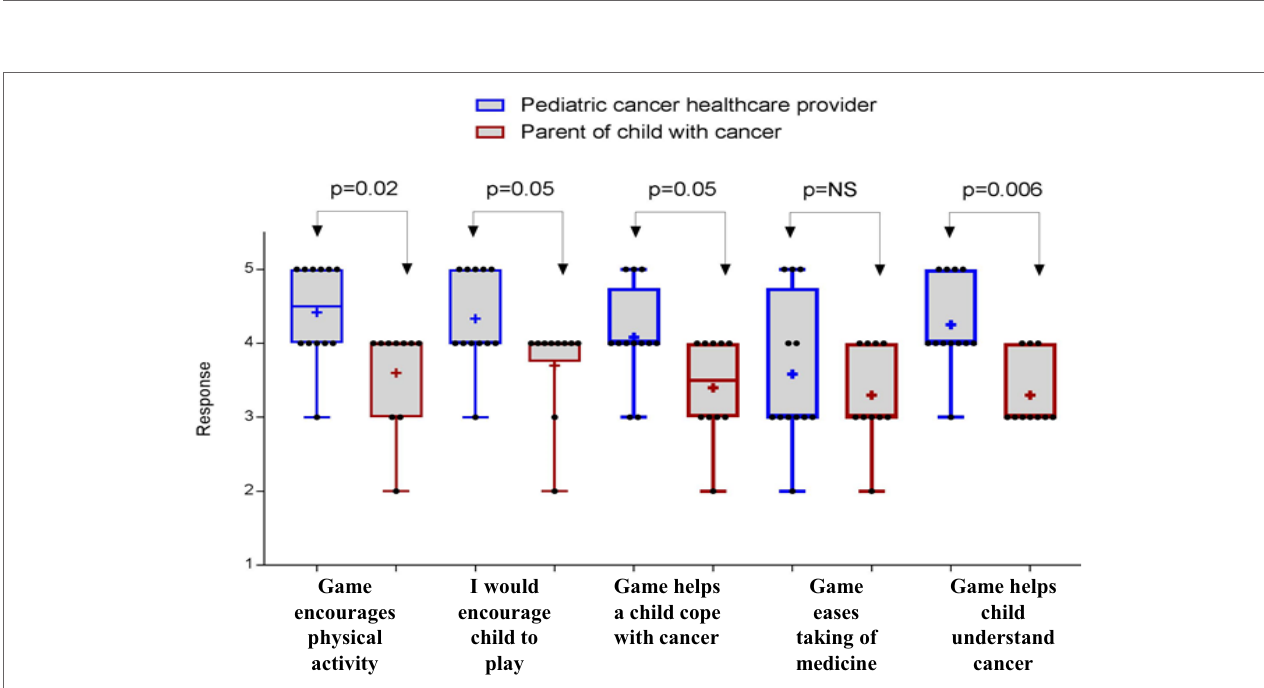
FigUre 13 | Five questions were asked to both health-care providers and parents of the children with cancer. Ratings were transformed to a scale of 1–5, and significant differences were assessed with a two-sided Wilcoxon–Mann–Whitney test. The “ + ” signs in the box-and-whiskers plots indicate the mean response of each group, box extends from the 25th to 75th percentiles, and a vertical line (when visible) drawn at the median response